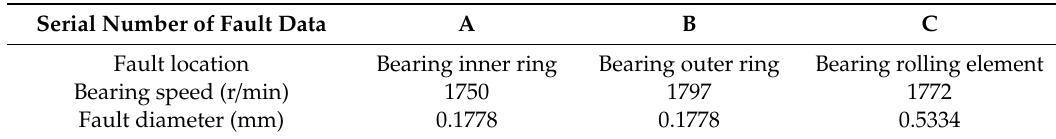
Table 3. Parameters table of fault data.